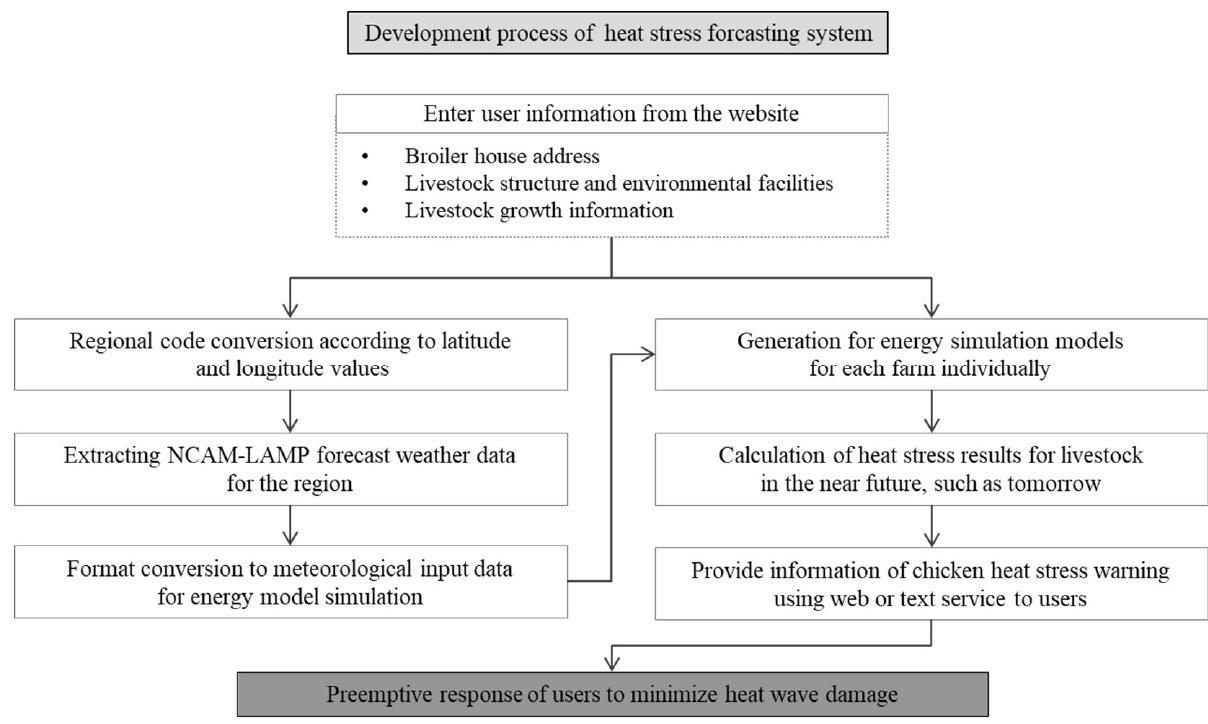
Figure 7. Research flow for heat stress forecasting system development procedure.